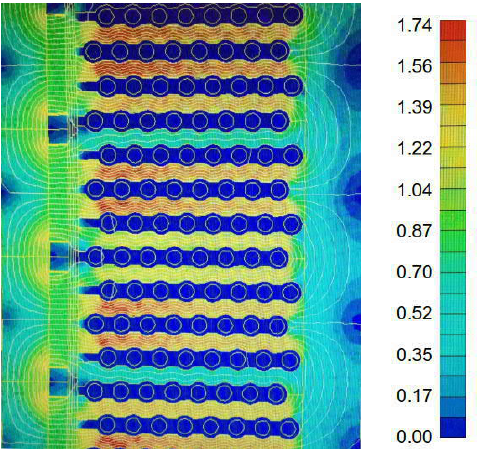
Figure 3. Field plot of the generator based on the original design from a FEM simulation, showing magnetic flux density in